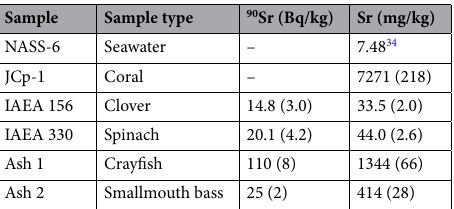
Table 2. 90 Sr activity of the environmental and biological samples and results of Sr abundance measurement. All the errors in the parenthesis are 2 SD.